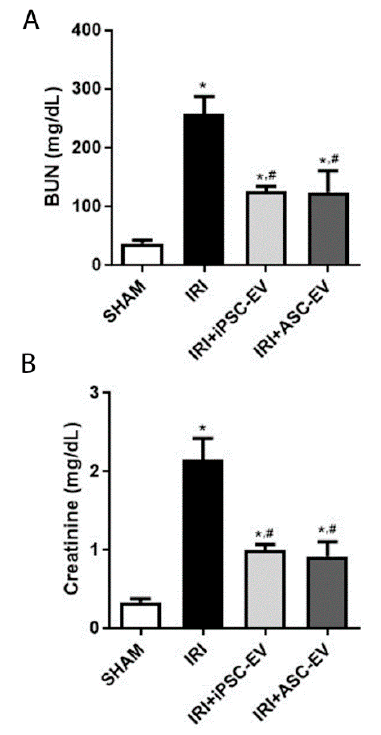
Figure 4. Administration of iPSC-EV after ischemia promoted the protection of kidney function. ( A ) Measurement of blood urea nitrogen (BUN) levels of the animals submitted to the different experimental conditions. The abscissa indicates each experimental groups: SHAM, IRI, IRI+iPSC-EV, and IRI+ASC-EV. The ordinate indicates the concentration of BUN (mg/dL). ( B ) Measurement of creatinine levels in the blood of the animals submitted to the different experimental conditions, as indicated in the abscissa. The ordinate indicates the creatinine concentration in the blood (mg/dL). In both analyses, SHAM, n = 4; IRI, n = 5; IRI+iPSC-EV, n = 11; IRI+ASC-EV, n = 5. Data represent mean ± SEM (* indicates statistical difference to SHAM group; # indicates statistical difference to IRI group; p <0.05 assessed by one-way ANOVA followed by Tukey’s test).